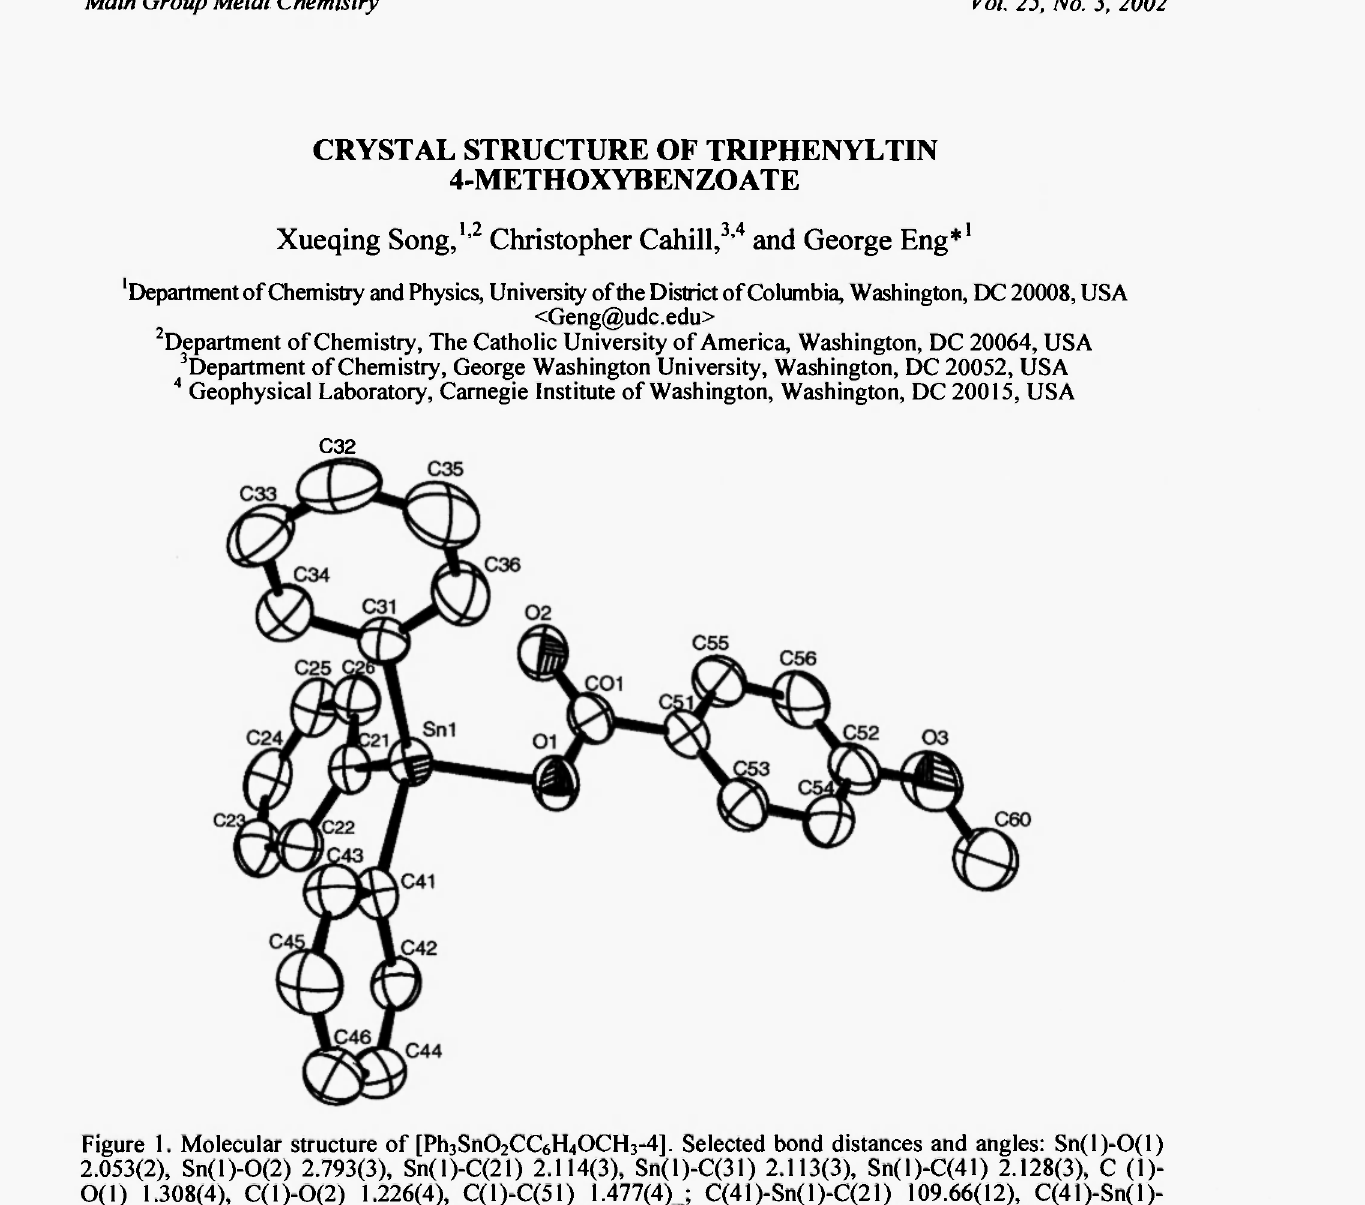
Figure 1. Molecular structure of [Ph3Sn0 2 CC 6 H 4 0CH3-4]. Selected bond distances and angles: Sn(l)-0(1) 2.053(2), Sn(l)-0(2) 2.793(3), Sn(l)-C(21) 2.114(3), Sn(l)-C(31) 2.113(3), Sn(l)-C(41) 2.128(3), C (1)- 0(1) 1.308(4), C( 1 )-0(2) 1.226(4), C(l)-C(51) 1.477(4) ; C(41)-Sn(l)-C(21) 109.66(12), C(41)-Sn(l)-